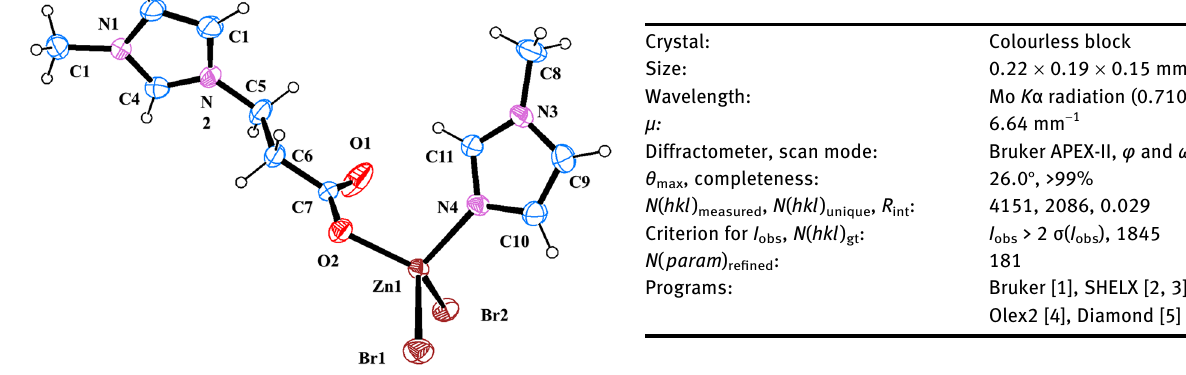
Figure 1: The asymmetric unit of the title compound.